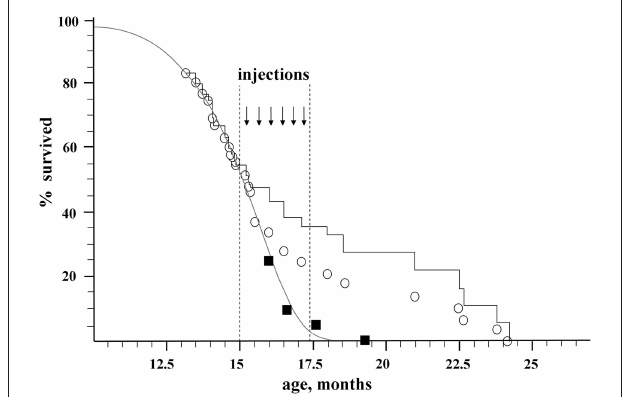
FIGURE 1 | Effect of nonablative transplantation of syngeneic BM of young donors on the population dynamics of aging recipients. Open circles, experimental group; black squares, control group; gray curve, Gompertz–Makeham curve of control group; black stepped curve, experimental group corrected for embolism (embolic animals